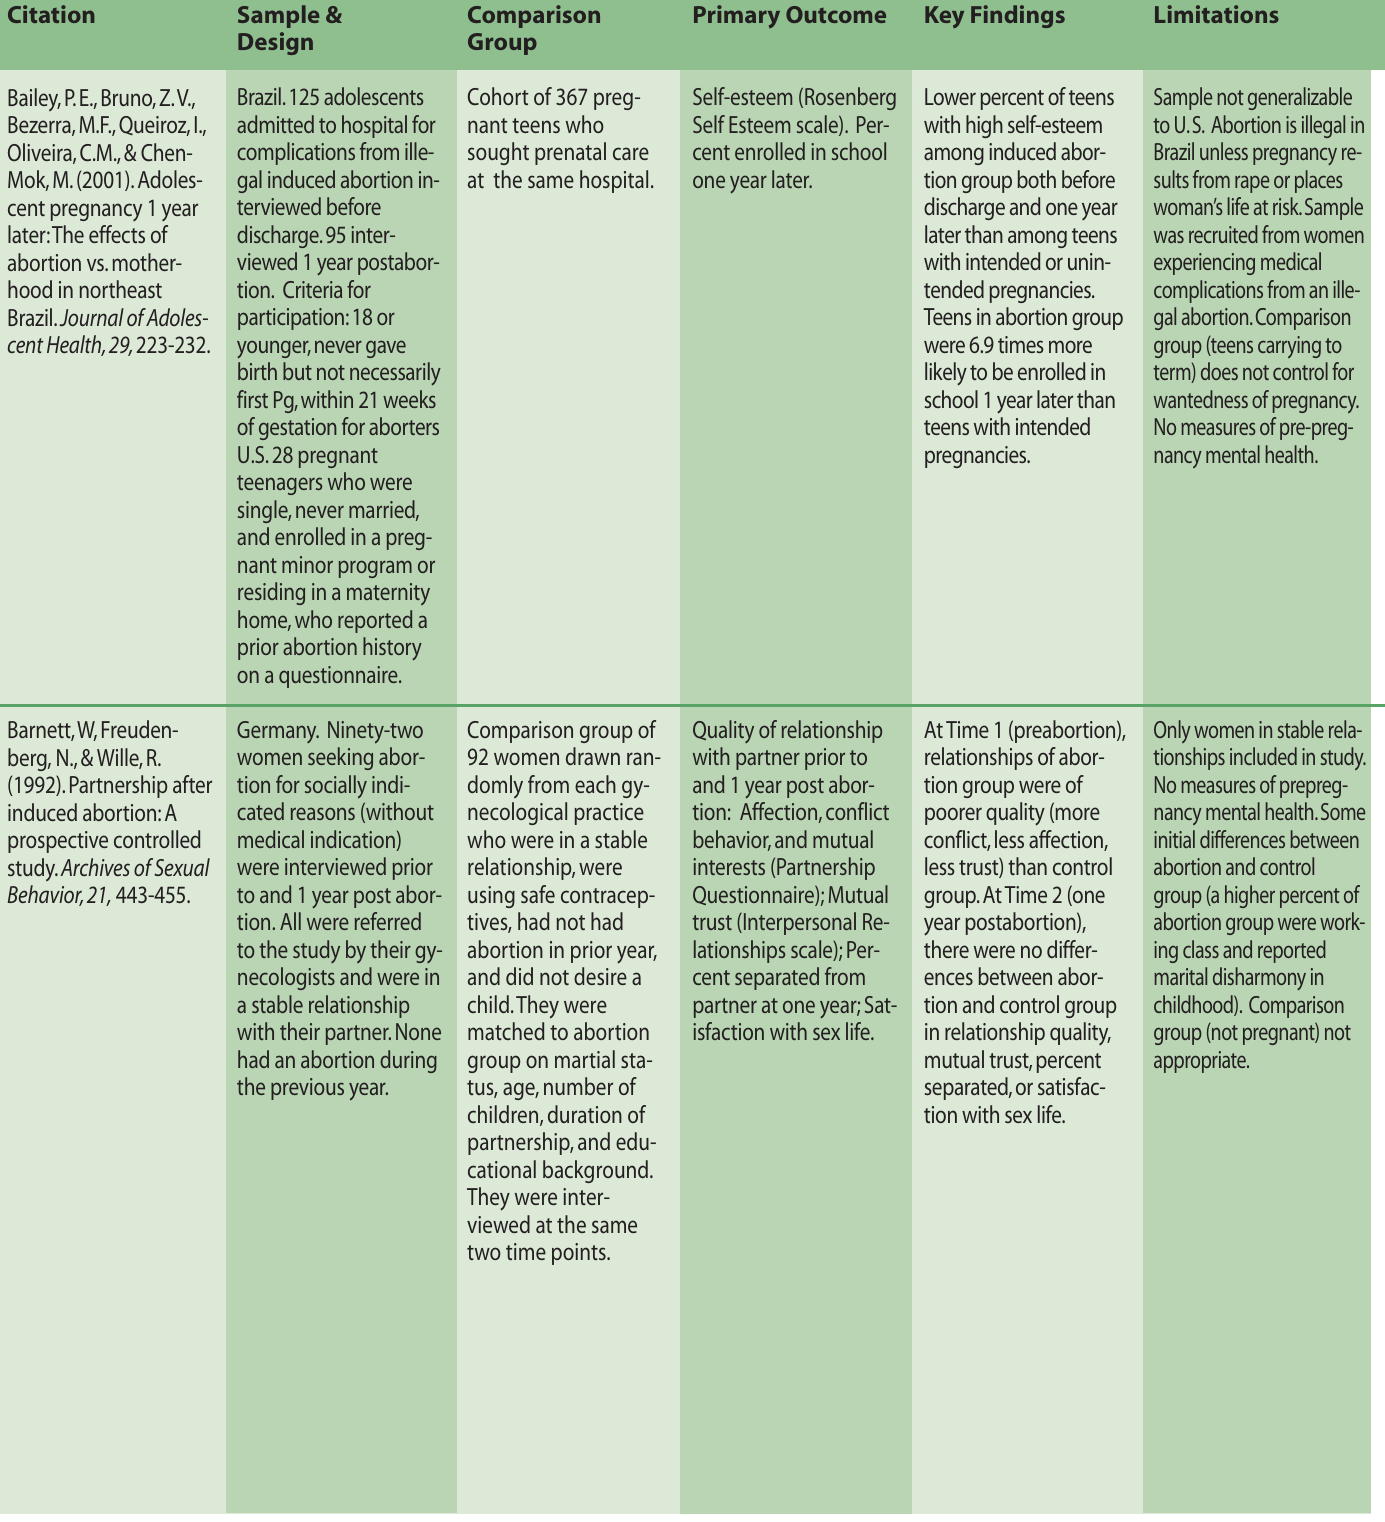
Table 3B: Comparison Group Studies